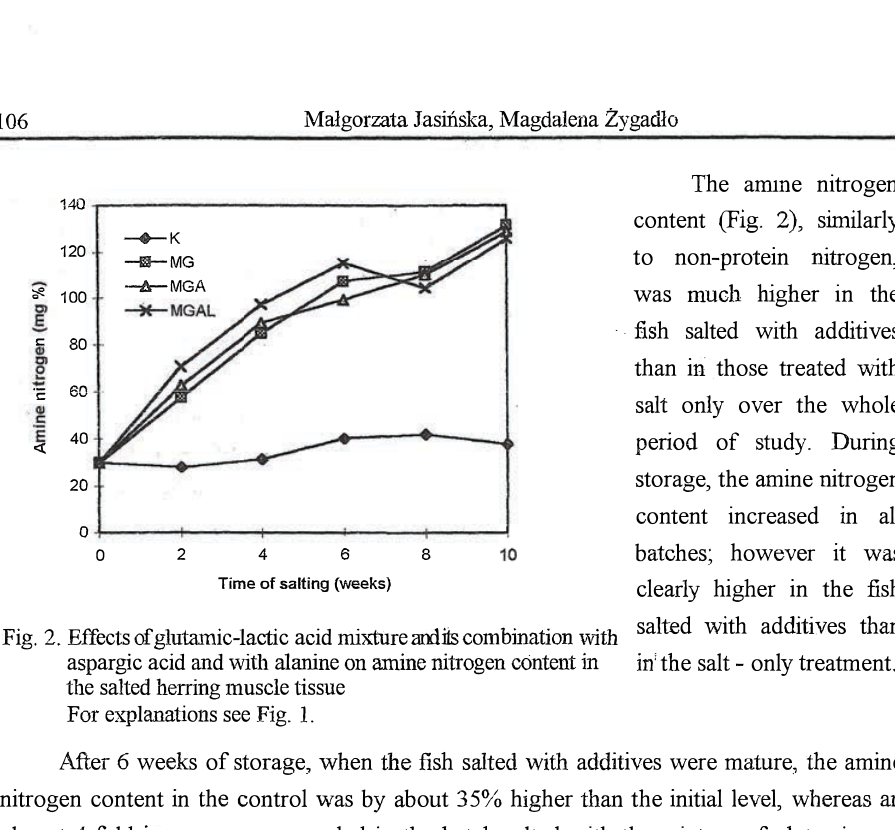
Results ofpair-vvise comparisons with StudeI].t'S t-test amine nitrogen content in the